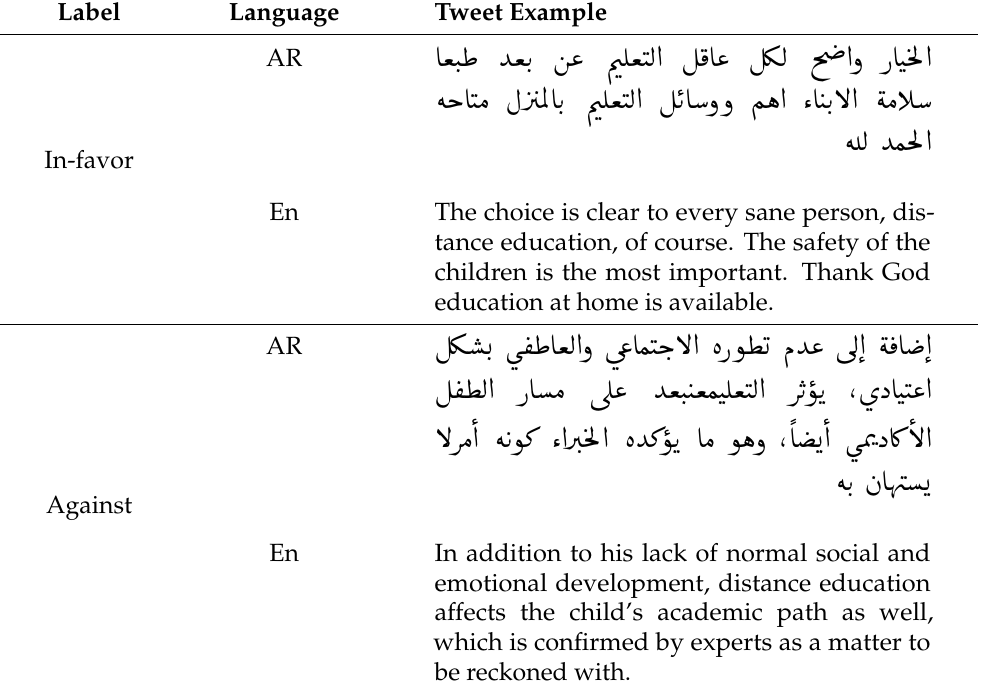
Table 5. Example of an In-favor and Against tweets along with their English